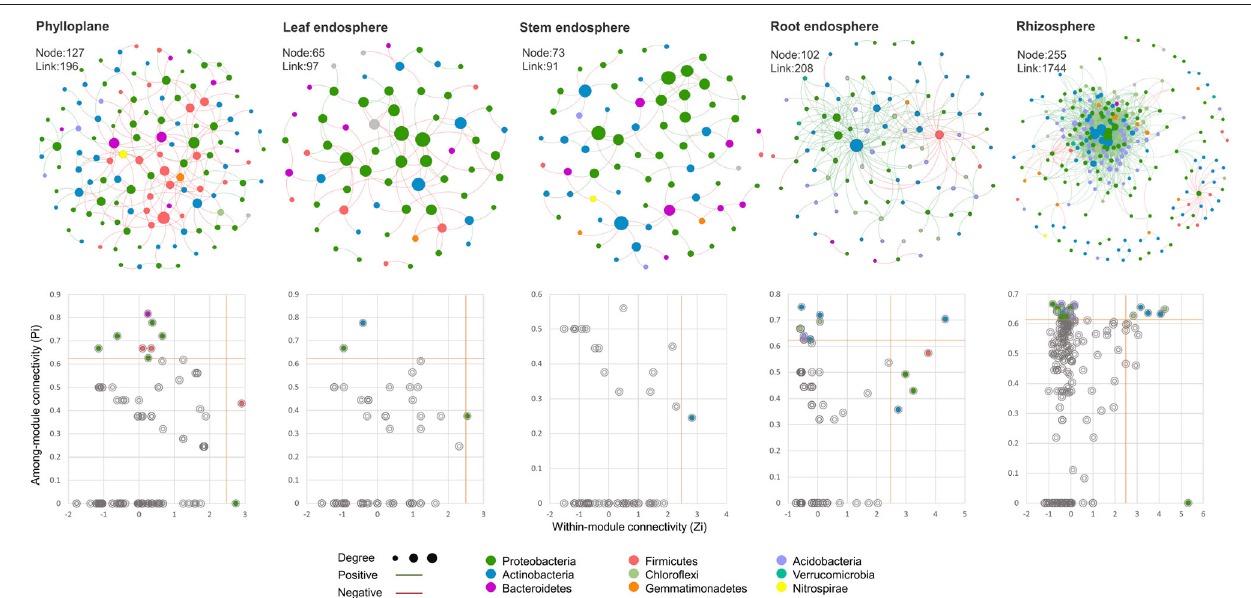
FIGURE 5 | The correlation networks of bacteria in different ecological compartments. One node represents an OTU, and the size of the node is determined by the degree. The larger the degree is, the larger the corresponding node size is, and the color of the node represents the microbial phylum which the OTU belongs. Line color indicates positive (green) or negative (red)